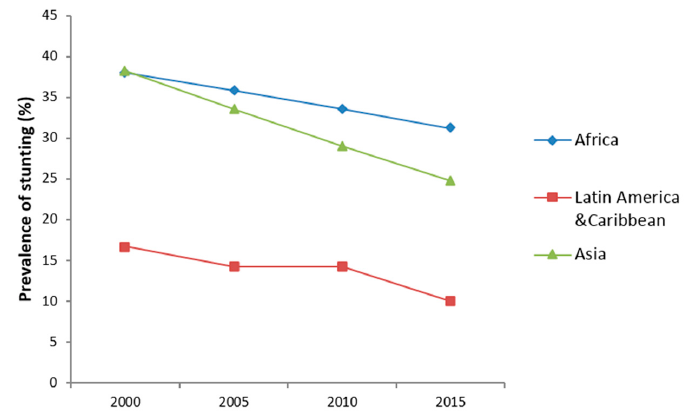
Figure 1. Average stunting reductions in regions with Low- and Middle-Income Countries (LMIC). Authors’ graph using UNICEF-WHO-The World Bank: joint malnutrition estimates [2].